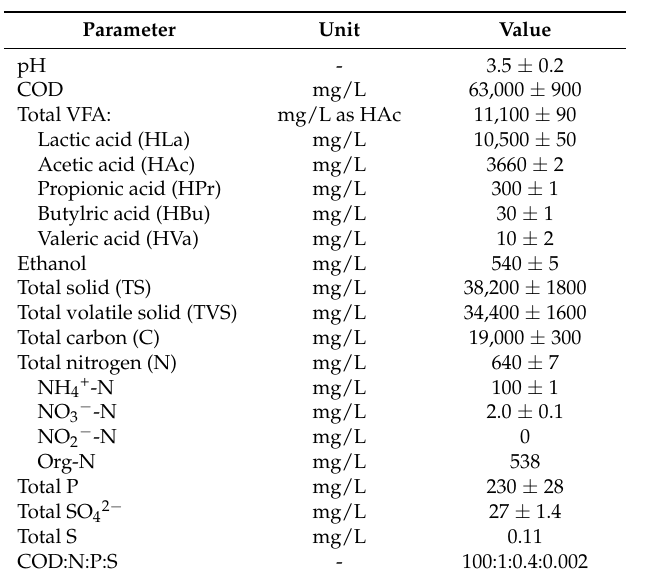
Table 2. Characteristics of the cassava-based ferment alcohol wastewater used in this